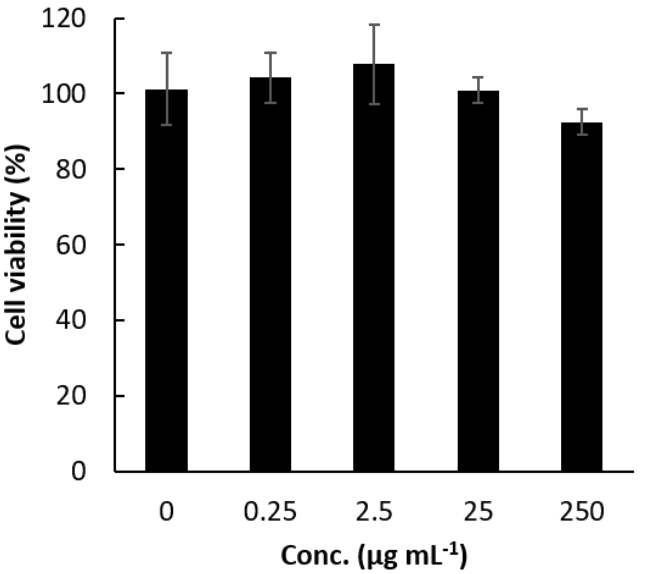
Figure 3. Cytotoxicity of PMETAC- co -PAMPAA(HpD) against RGM-1 cells, which is the gastric epithelial cell line . Data are shown as mean ± standard deviation ( n = 4).